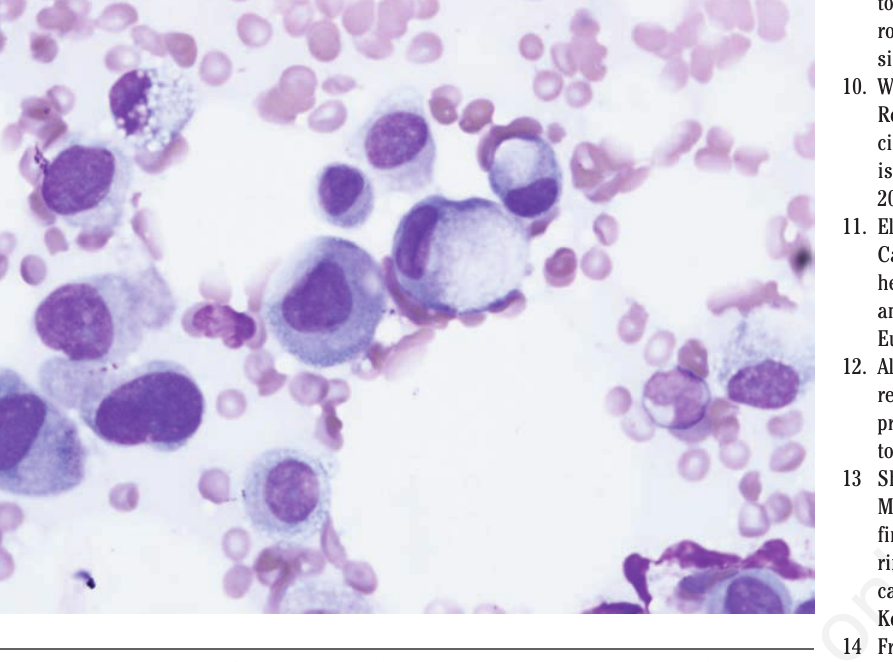
Figure 3. Wright’s stain of bone marrow biopsy demonstrating signet ring